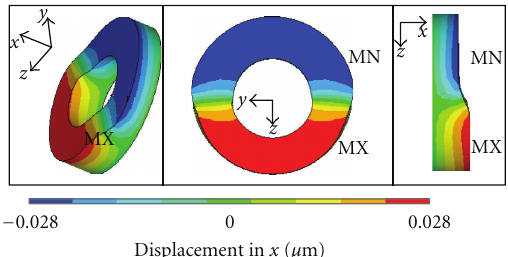
Figure 7: FEM calculation of the divided piezoceramic ring.